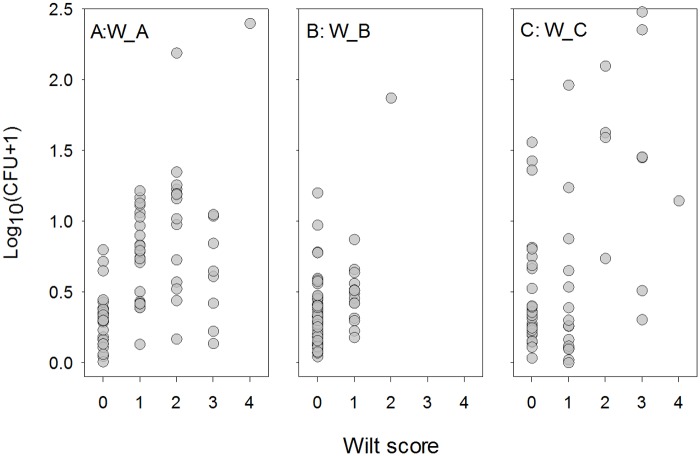
Estimated Verticillium dahliae inoculum densities in soil plotted against wilt scores of individual plants.These plantations (W_A, W_B, W_C) were located in Weinan, Shaanxi. The distance between soil sampling points and the plant stem was ca. 15 cm. Wilt on each plant in each plant was scored as: 0—no symptoms; 1—leaves with wilt symptoms ≤ 25%; 2—leaves with wilt symptoms > 25% and ≤ 50%; 3—leaves with wilt symptoms > 50% and ≤ 75%; and 4—>75% leaves with wilt symptoms.